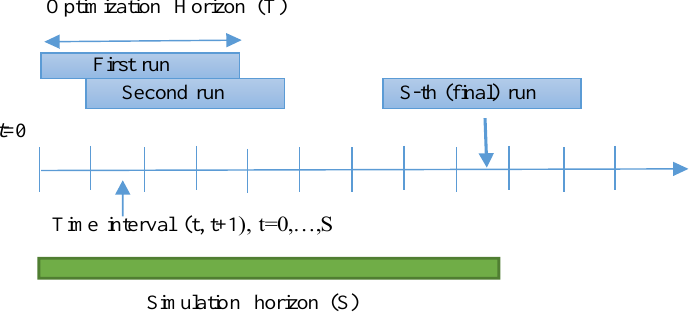
Figure 2. A pictorial representation of the receding horizon control scheme.